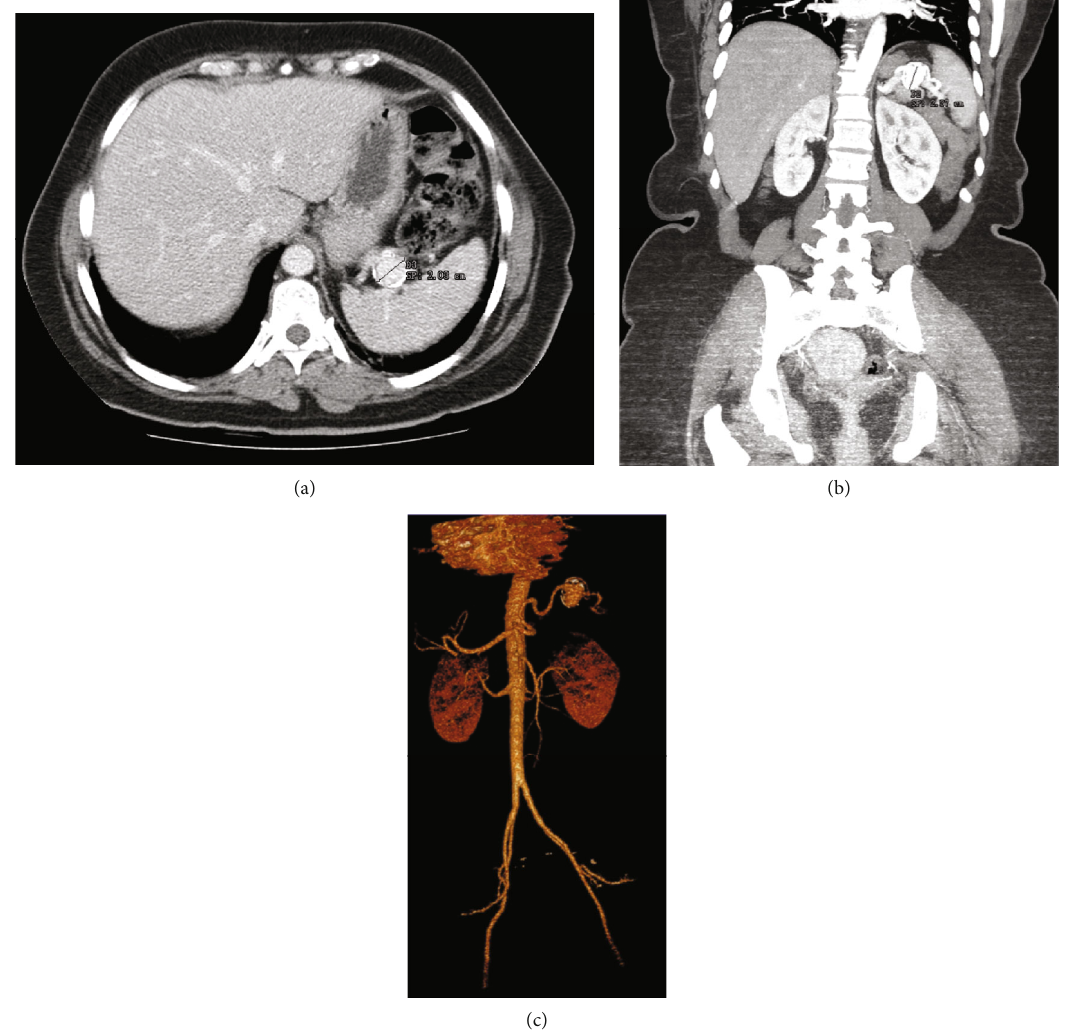
Figure 1: A 50-year-old female patient with an angioCT scan showing a splenic artery aneurism. (a) Transversal cut section. (b) Coronal cut section. (c) 3D angioCT